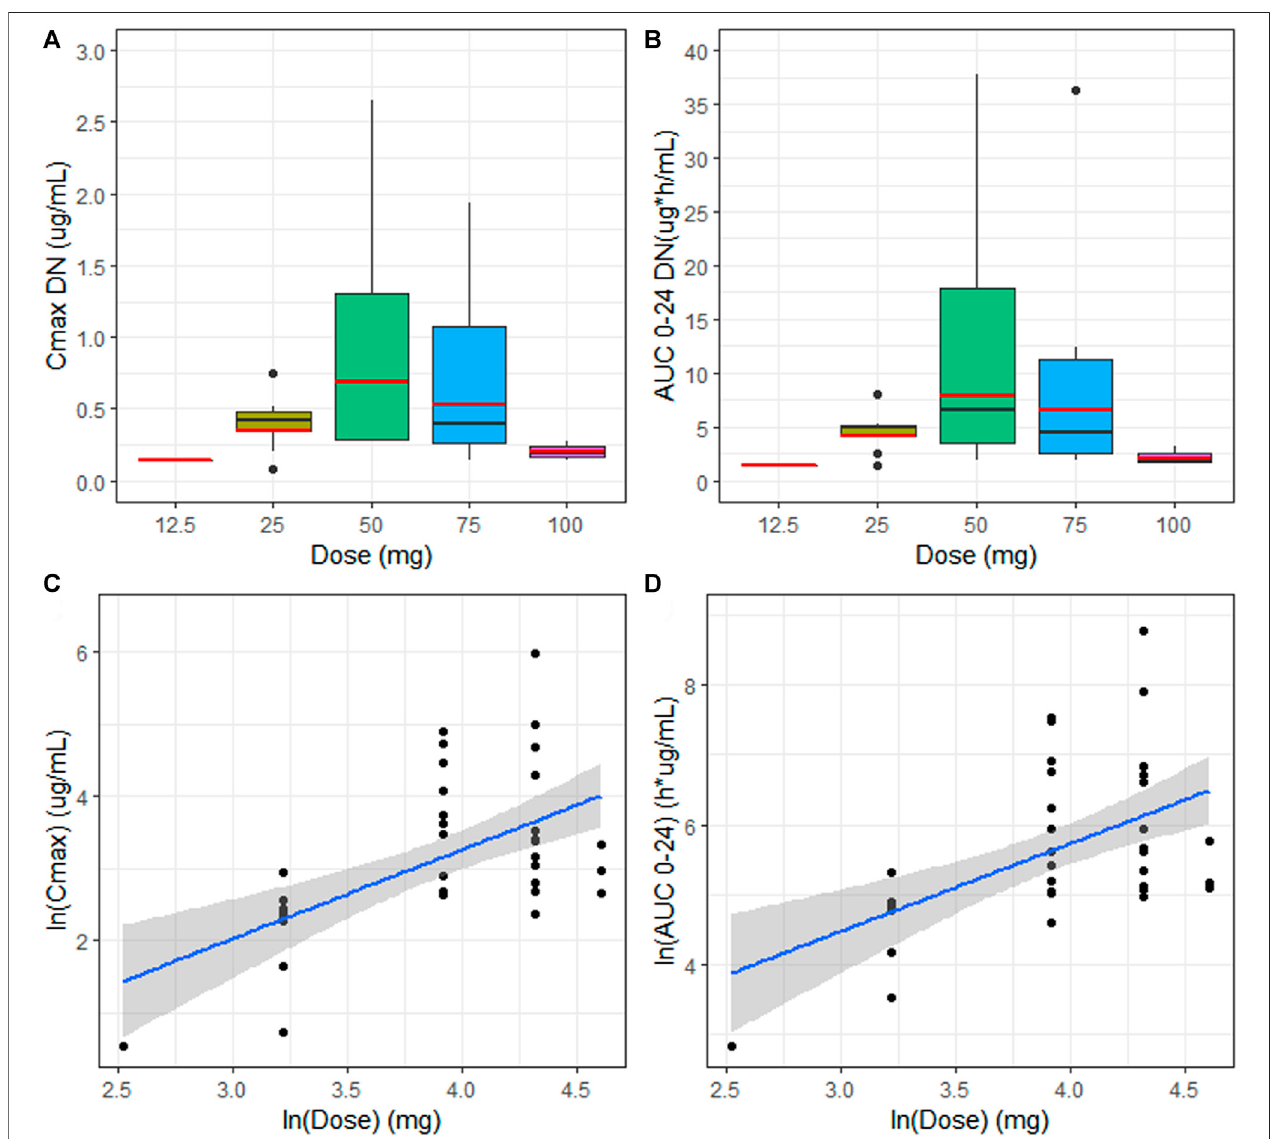
FIGURE2|(A,B) Median(black line)and geo-mean(redline)ofdose-normalized Cmax(CmaxDN)anddose-normalized AUC0 – 24(AUC0 – 24DN)vs.dose(mg) for the evaluation of dose proportionality. (C) Linear regression model with the best fi t line (blue) and 90% CI (gray area) describing relationship between the extent of systemic exposure including Cmax and AUC 0 – 24 (D) and